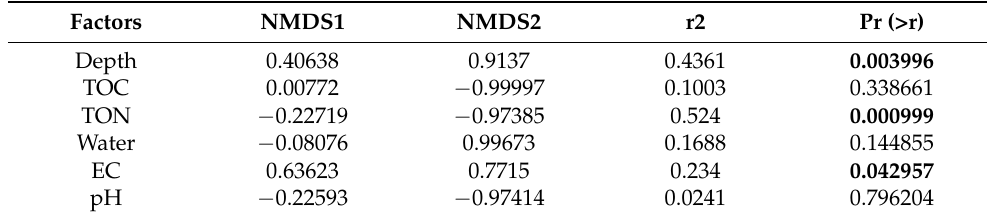
Table 2. Results of envfit function showing the relationship of chemical/physical parameters with Non-metric multidimensional scaling (NMDS) ordination of the permafrost-associated fungal commu- nities. TOC, total organic carbon; TON, total organic nitrogen; EC, electrical conductivity. Significant ( p < 0.05) p values are shown in